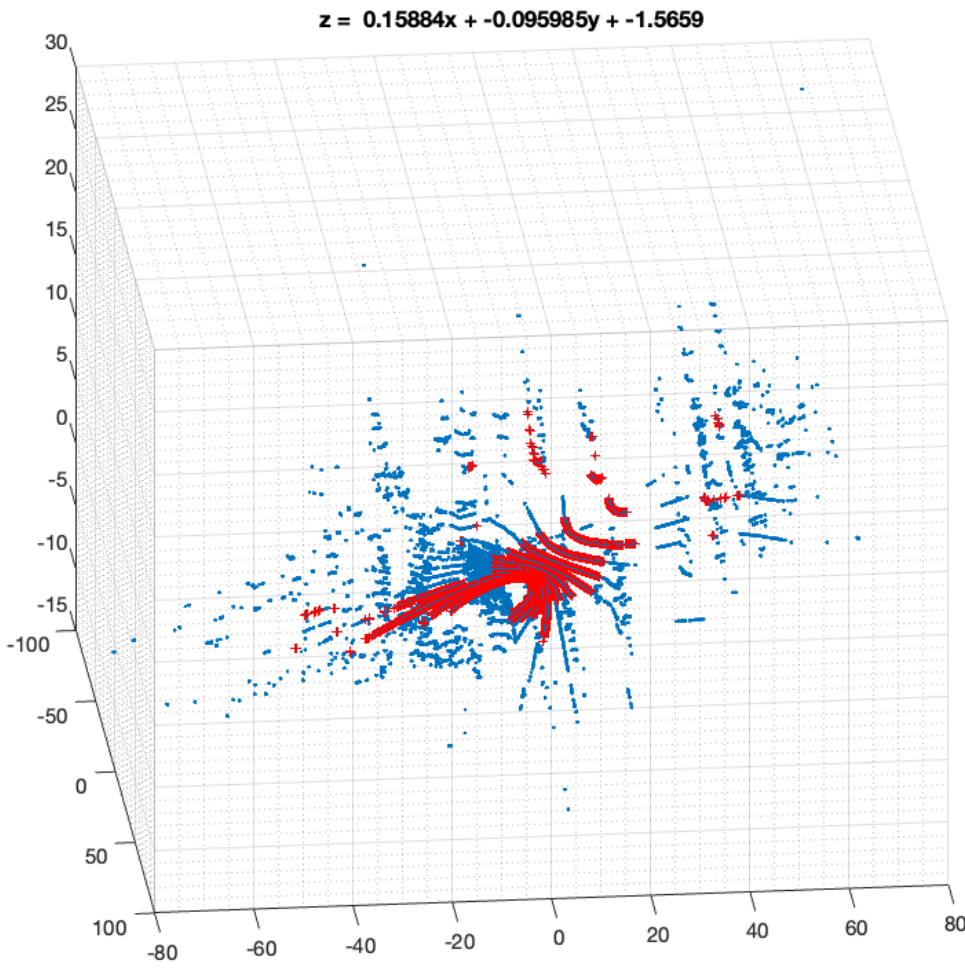
Figure 11. Ground plane detection